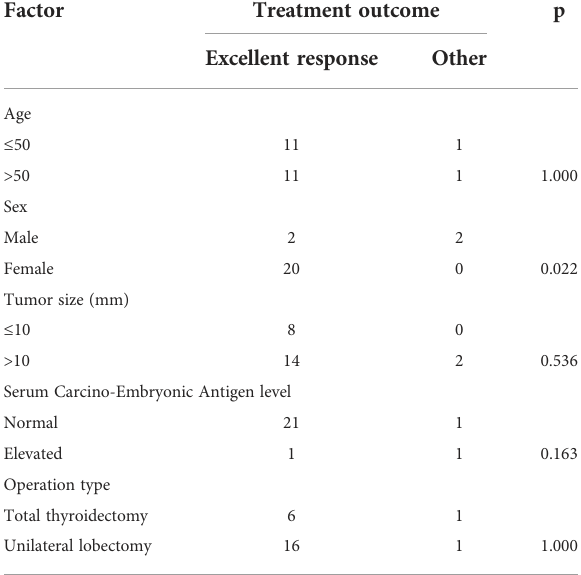
TABLE 4 Association between clinicopathologic factors and treatment outcome in negative group. Factor